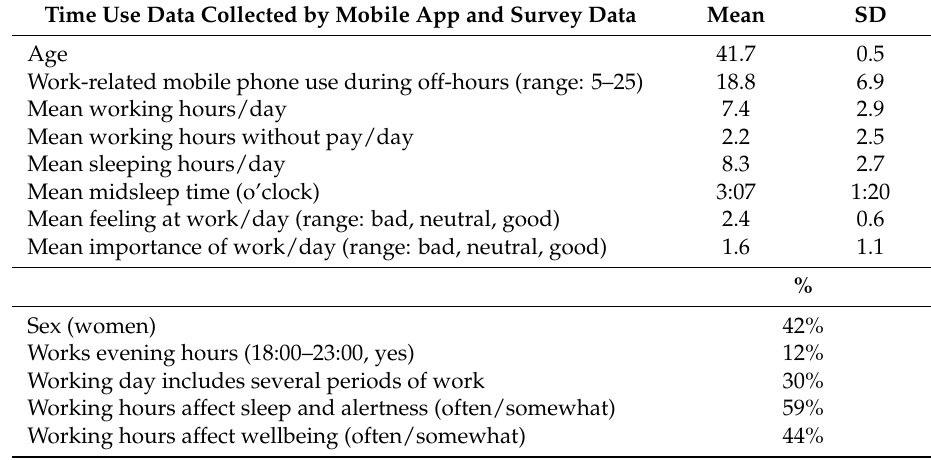
Table 1. Descriptive statistics for background, time use, sleep, alertness, and wellbeing of 154 individuals. Time Use Data Collected by Mobile App and Survey Data Mean